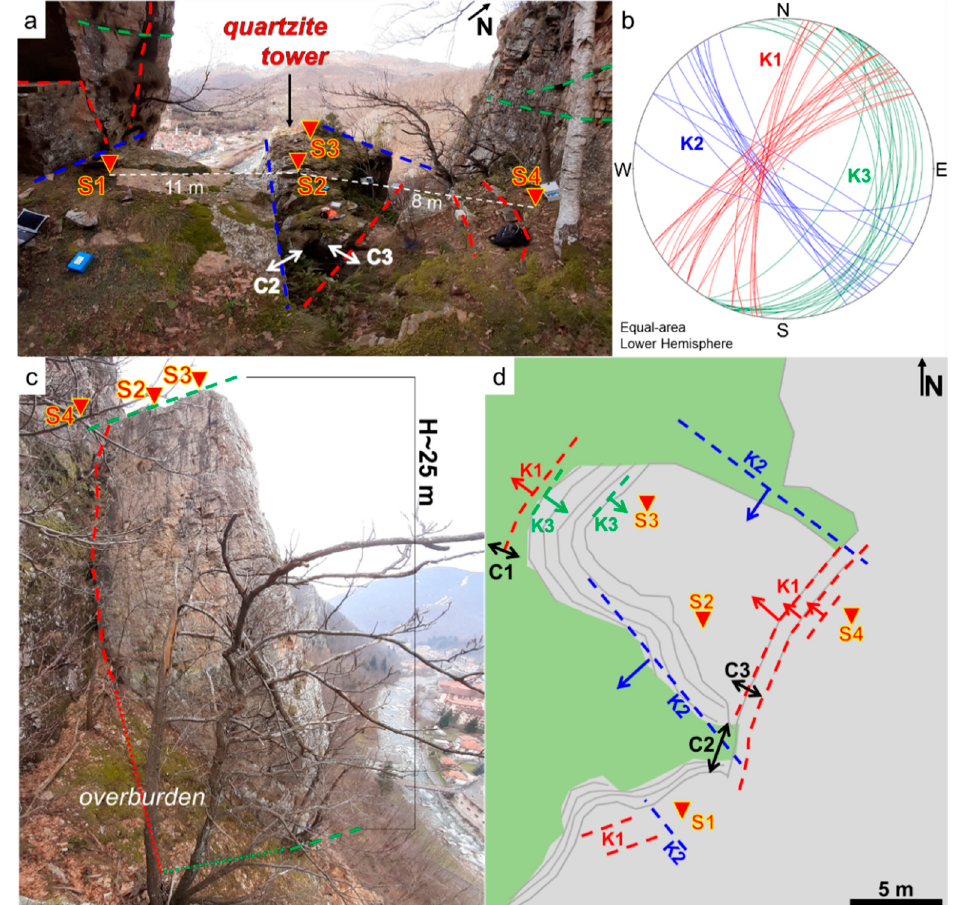
Figure 2. Geometry of the study site and monitoring network ( a ) Wide-angle view of the top of the quartzite tower (S1 to S4: passive seismic stations; C1 to C3: extensometers). ( b ) On-site measured orientations of fracture planes. ( c ) Side view of the tower. ( d ) Simplified planar view of fracture and sensor locations. In all panels, main fracture directions are highlighted by colored dashed lines (the arrows mark the dip direction). Three fracture sets were identified (dip direction/dip): K1 (310/75, in red); K2 (235/80, in blue); K3 (110/25; in green).